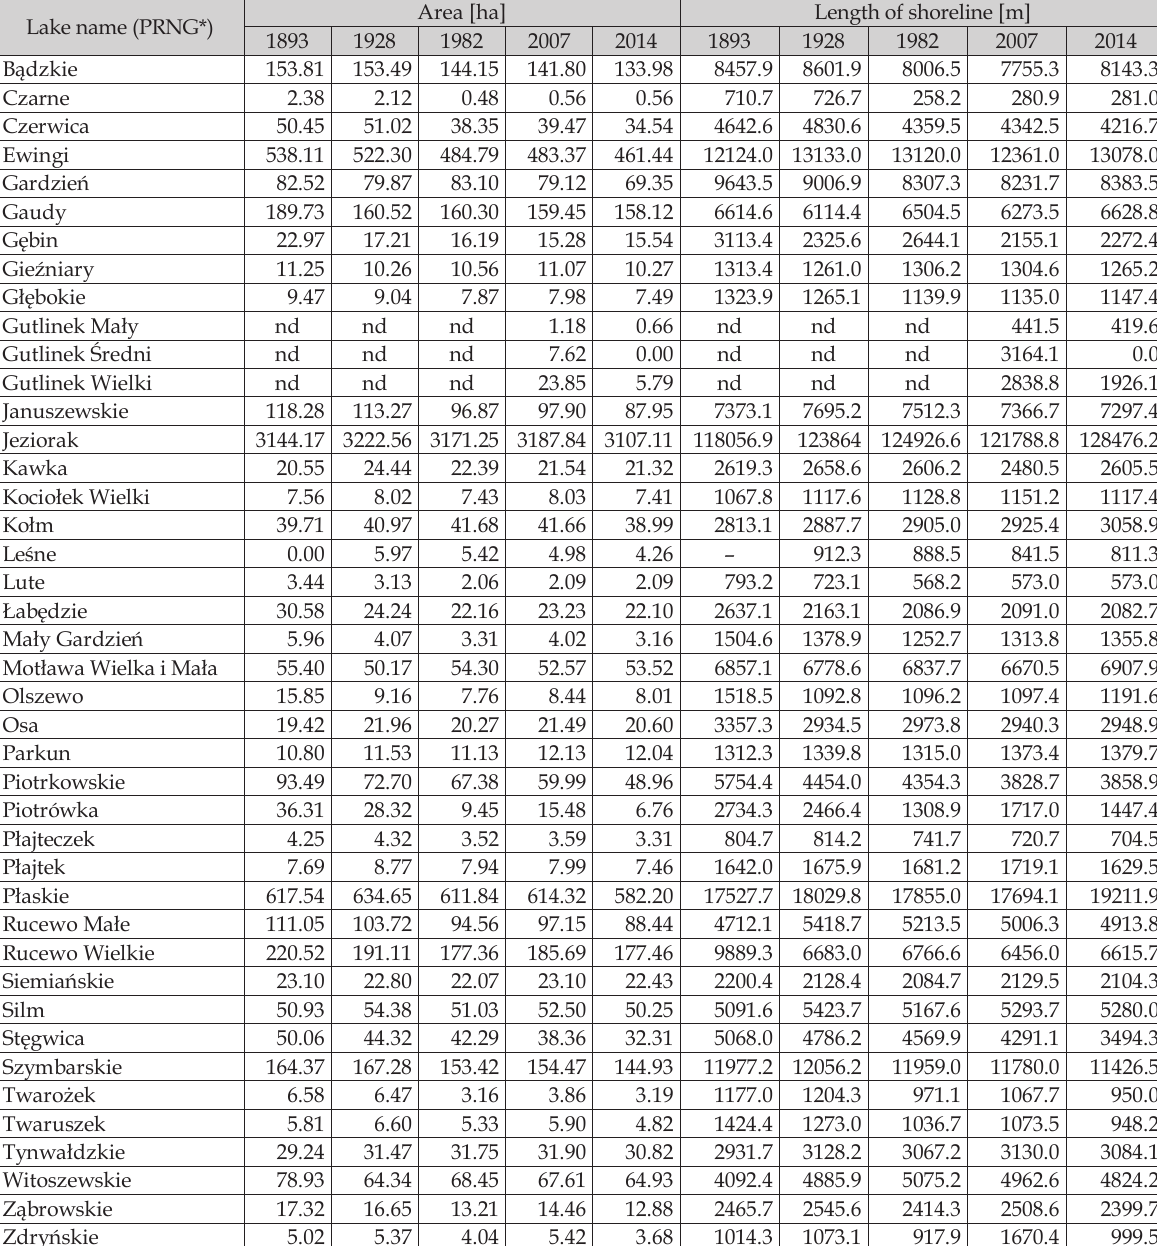
Table 1. Area and length of shoreline for chosen lakes of the Iława Lakeland Landscape